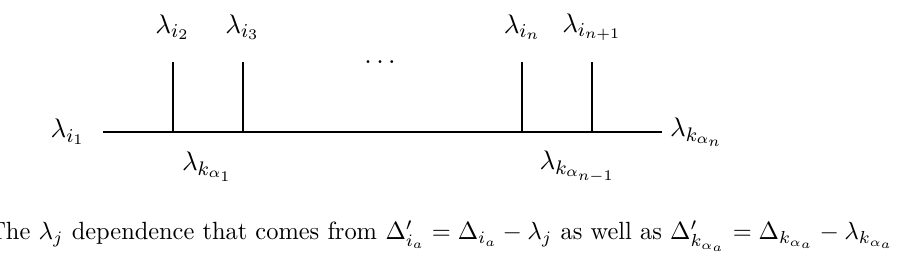
Figure 18 . The λ j dependence that comes from ∆ 0 the final comb structure figure